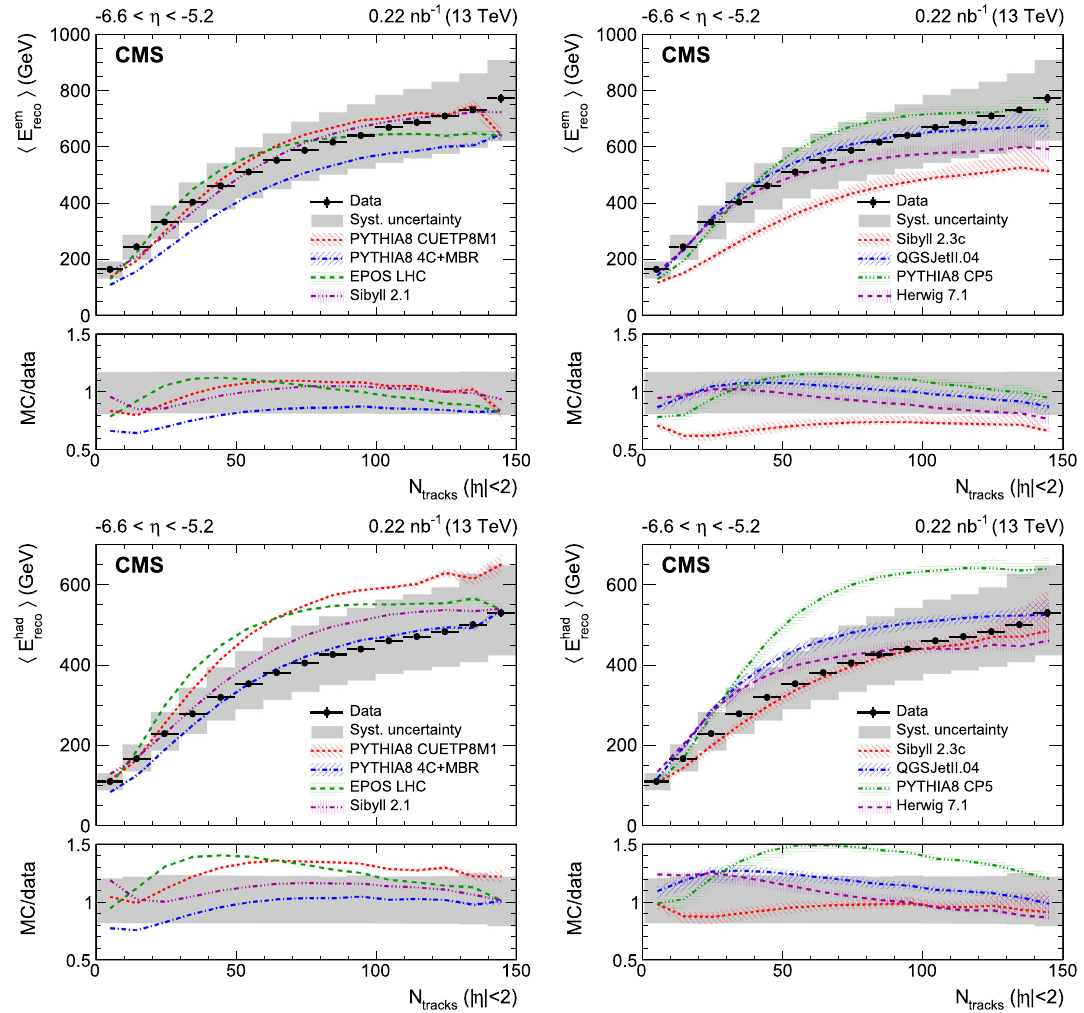
Fig. 2 Top panel: Average electromagnetic energy reconstructed in the CASTOR calorimeter as a function of the number of reconstructed tracks for | η | < 2. Bottom panel: Average hadronic energy recon- structed in the CASTOR calorimeter as a function of the number of reconstructed tracks for | η | < 2. In all figures, the data are shown with